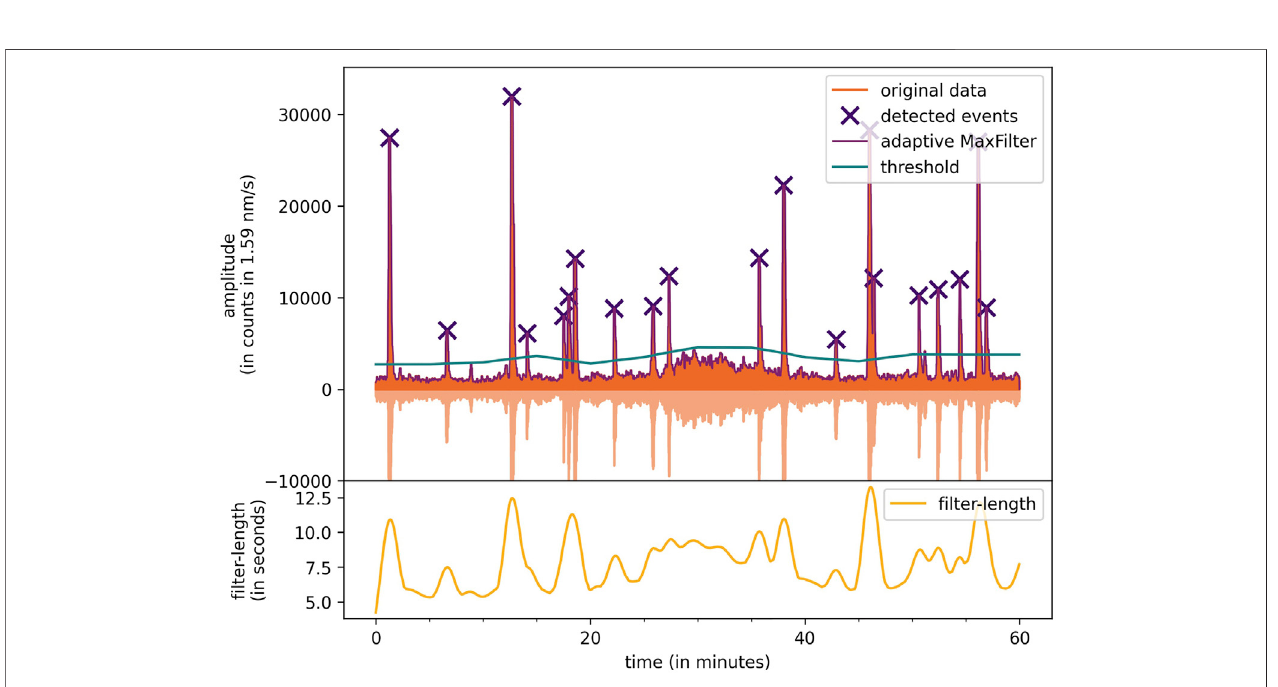
FIGURE 5 | Seismo-volcanic event detection algorithm on example data. The adaptive prominence threshold and fi lter-size is shown.